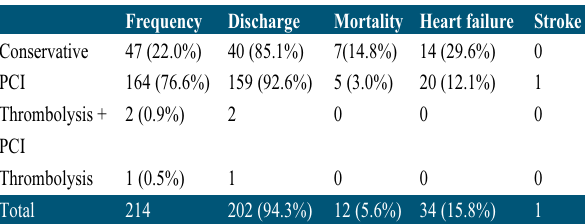
PCI: Percutaneous coronary intervention Discussion